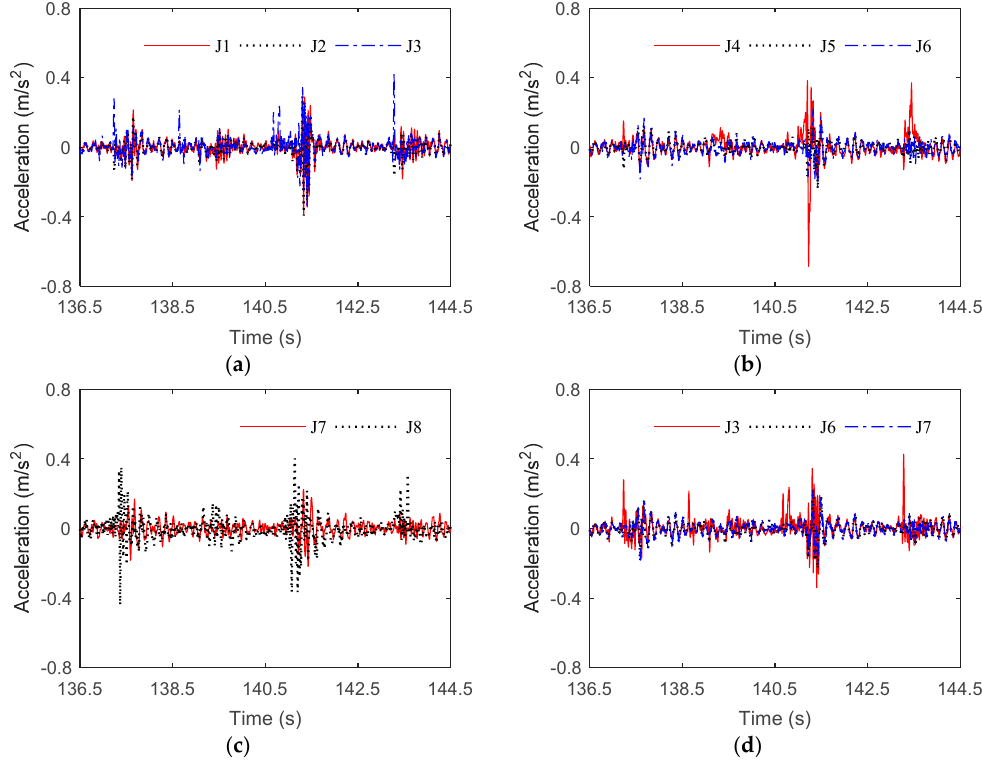
Figure 14. Time-series of the acceleration response at various measurement positions in storm condition C2. ( a ) J1, J2, J3; ( b ) J4, J5, J6; ( c ) J7, J8; ( d ) J3, J6, J7.